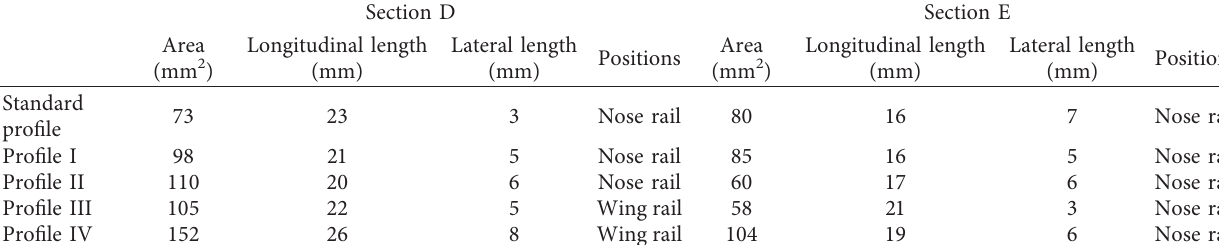
Table 3: The contact spot size and contact position of each type of profile at Section D and Section E. Section D